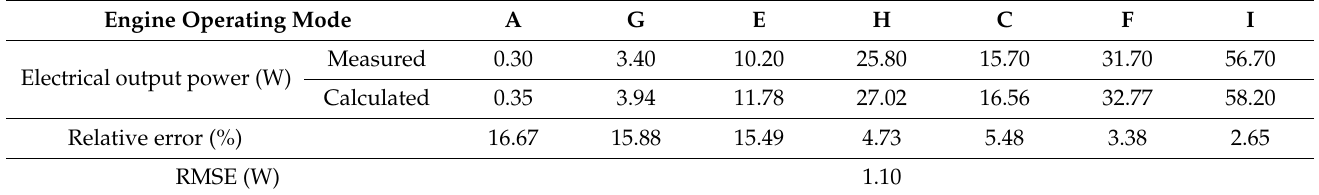
Table 4. Experimental values vs. theoretical